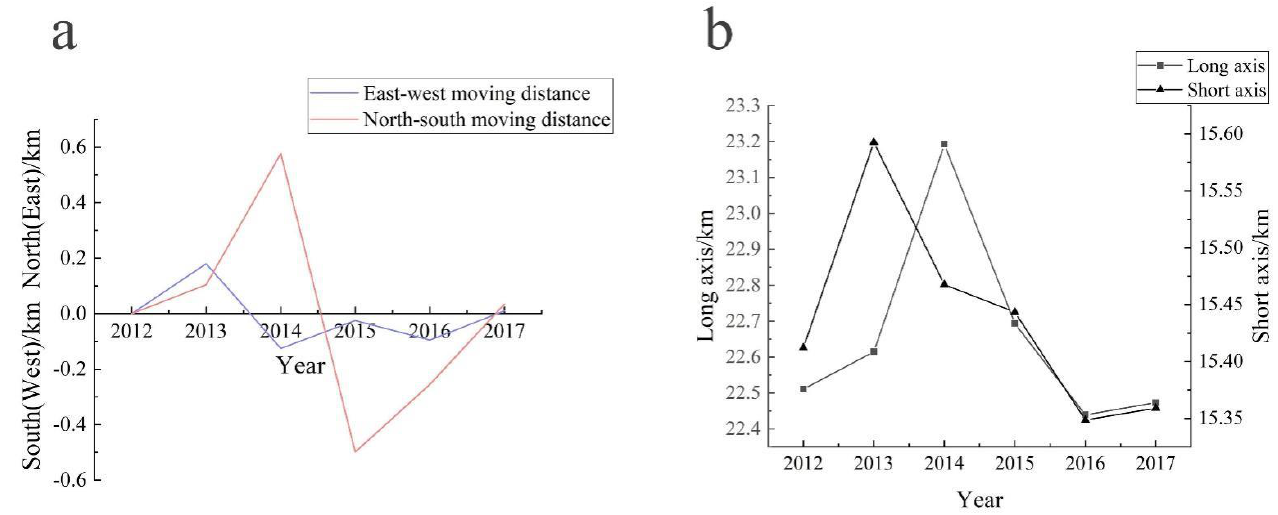
Figure 7. The moving distance ( a ) of gravity center of the digestive tract cancer in residents of Lujiang County and the variation of short and long axis ( b ) from 2012 to 2017.